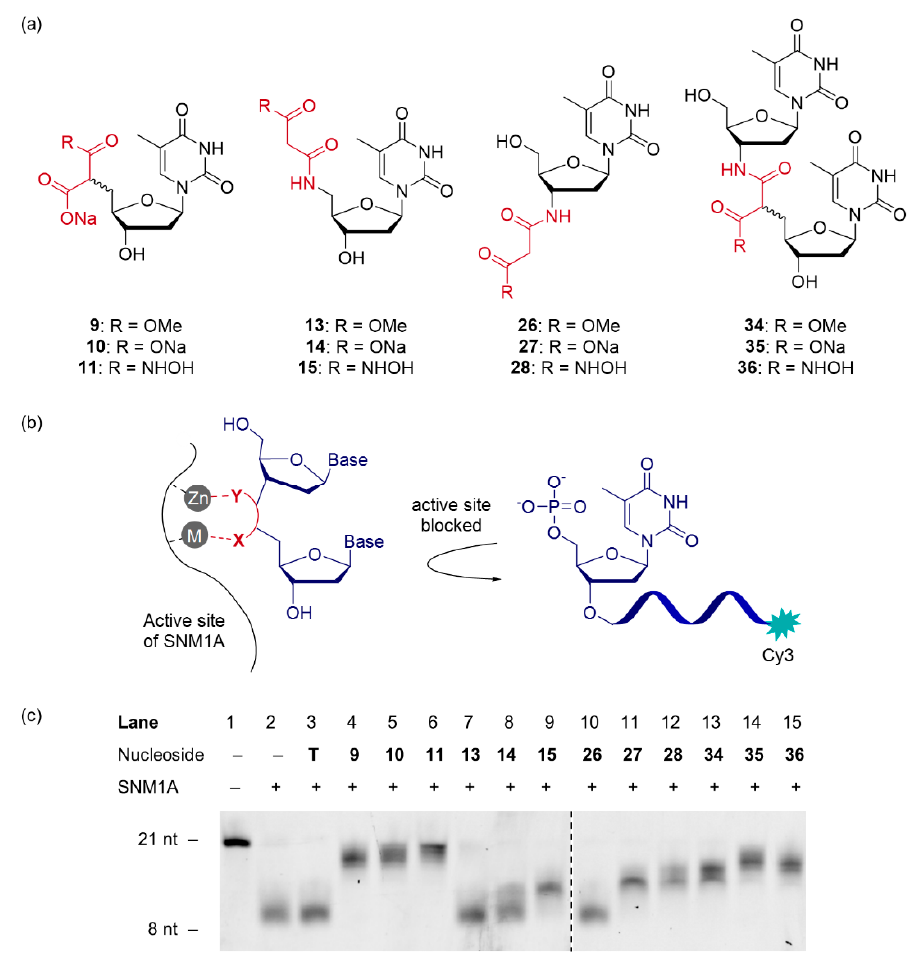
Figure 2. Evaluation of modified (di)nucleosides as inhibitors of SNM1A. ( a ) Structures of the twelve (di)nucleosides that were evaluated as inhibitors of SNM1A; ( b ) schematic representation of assay; ( c ) gel electrophoresis showing the extent of digestion of fluorescent 21-mer oligonucleotide substrate. SNM1A (2.5 nM) was pre-incubated with the modified (di)nucleosides (1 mM) for 5 min before the oligonucleotide substrate (80 nM) was added and a further 60 min incubation. nt = nucleotides.